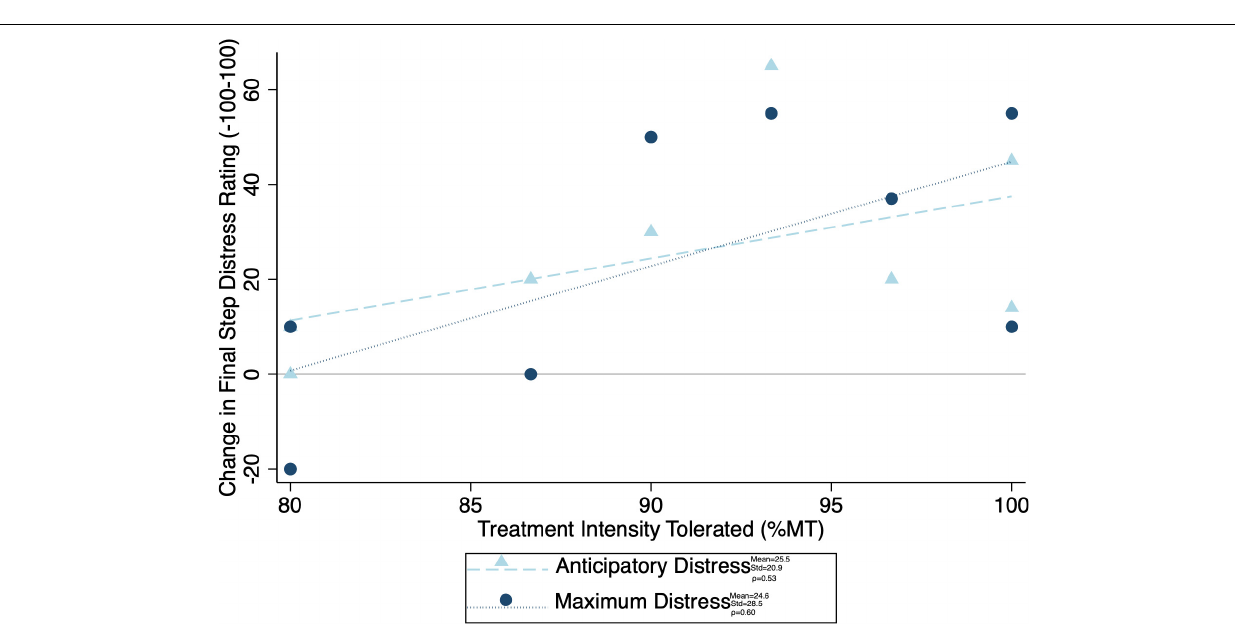
FIGURE 8 | Correlation between maximum treatment intensity tolerated and final common step distress (both anticipatory and maximum experienced distress shown). Change in distress was calculated as pre minus post, with positive values indicating a decrease in distress with treatment. Mean change in distress, standard of deviation of the change in distress, and spearman correlation coefficient ( ρ ) for both anticipatory and maximum distress